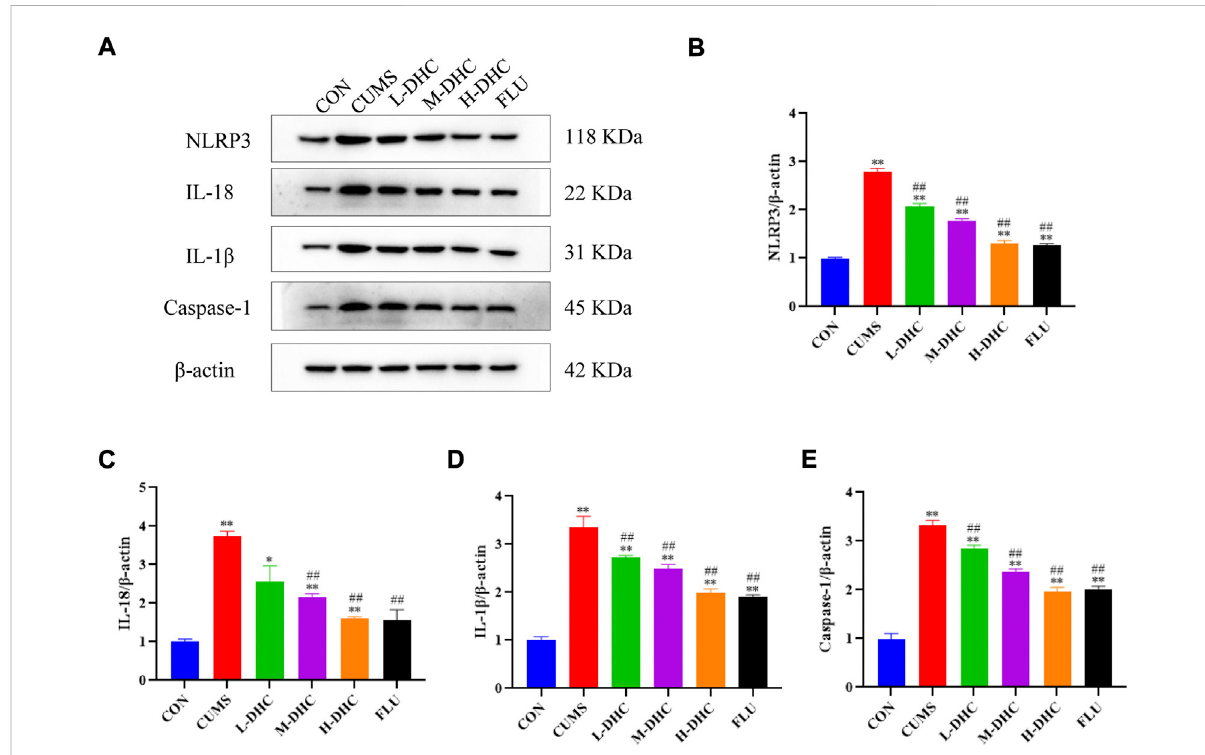
FIGURE 5 Effects of DHC or fl uoxetine on NLRP3 in fl ammasome activation in CUMS-induced depression in mice. (A) Image of NLRP3 in fl ammasome- associated protein in the hippocampus. β -actin was used as an internal reference, (B) the expression level of NLRP3 protein, (C) the expression level of IL-18 protein, (D) the expression level of IL-1 β protein, and (E) the expression level of caspase-1 protein. * p < 0.05 and ** p < 0.01, compared with the control (CON) group; # p < 0.05 and ## p < 0.01, compared with the CUMS